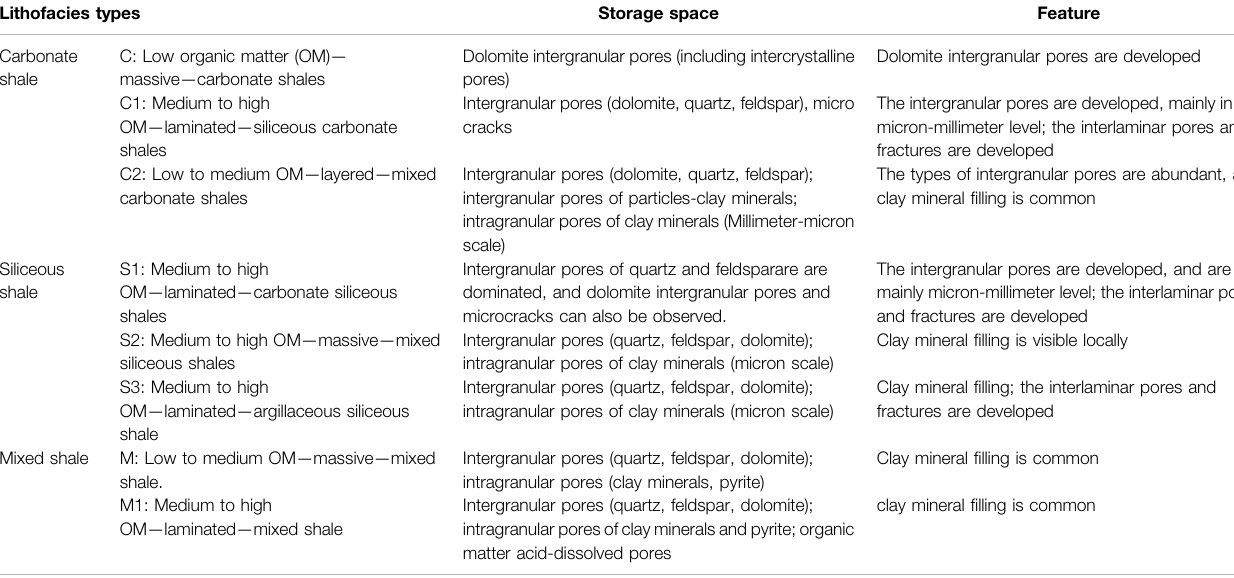
TABLE 1 | Spatial characteristics and classi fi cation of EK 2 lacustrine shale reservoirs in the study area.